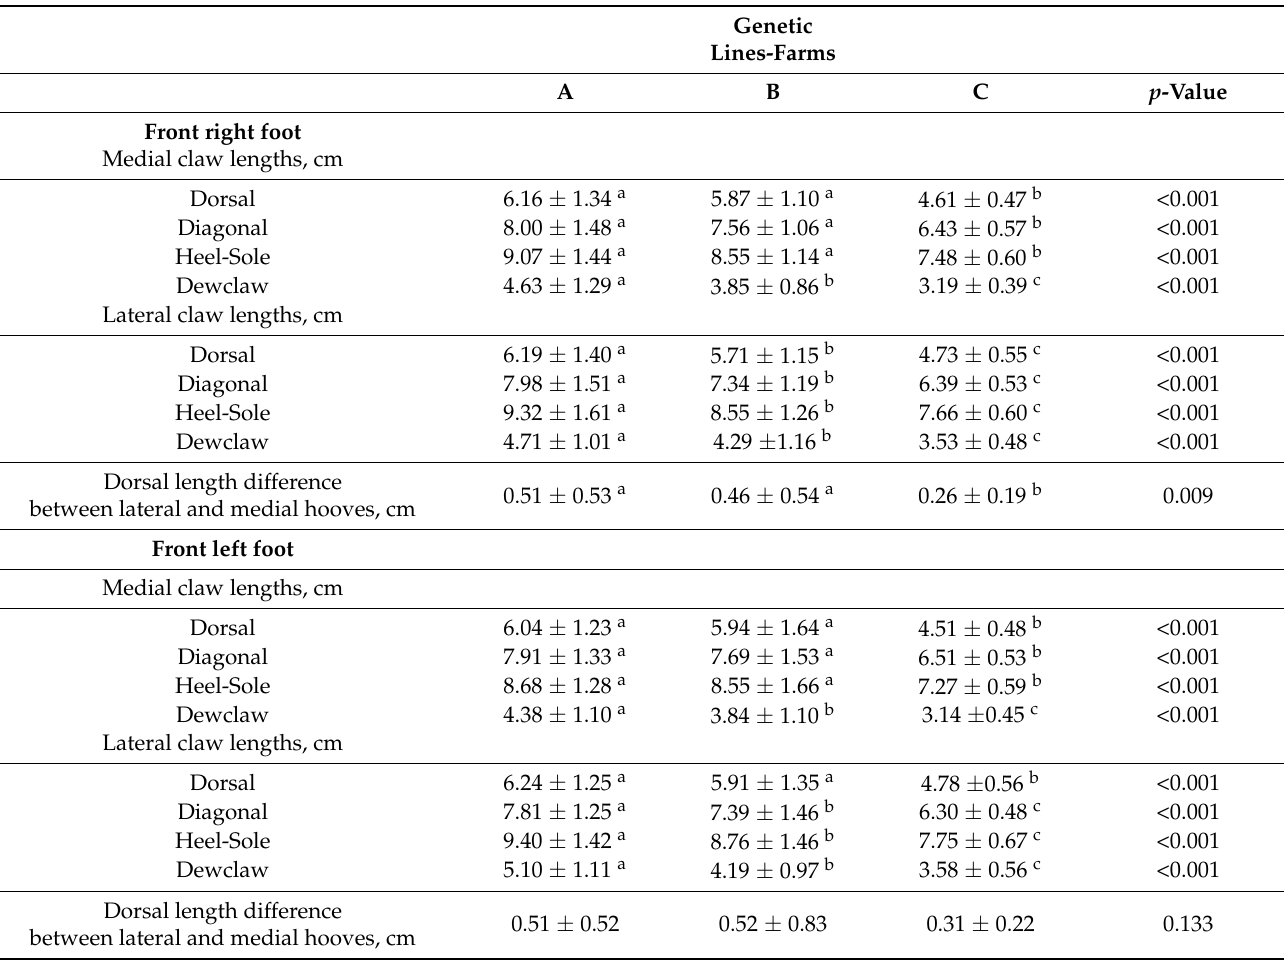
Table 2. Claw lengths: Dorsal, the distance from the dorsal skin-horn junction (periople) to the apex of the toe; Diagonal, the distance from the apex of the toe to the skin-horn junction at the heel; Heel-Sole, the length of the abaxial wall (sole) and bulb (heel) that are in contact with the floor surface from the top of the toe to the caudal end of the heel; Dewclaw (along dorsal wall from just below the coronary band to the end of the wall); Dorsal length difference between lateral and medial hooves, expressed as mean ± SD of culled sows’ front feet from three pig farms (A, B, C). The sows of each farm belonged to different genetic lines (Farm A: PIC; Farm B: Danbred; Farm C: Topigs). Genetic Lines-Farms A B C p